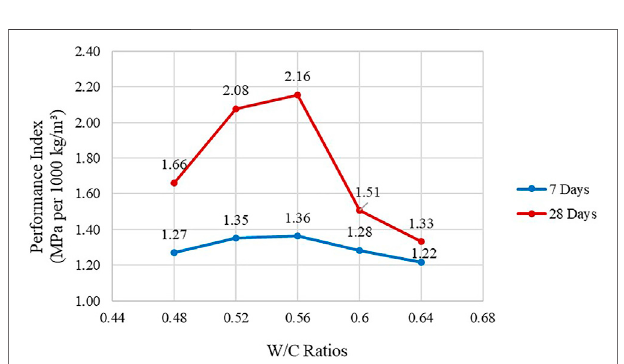
FIGURE 5 | Performance index of